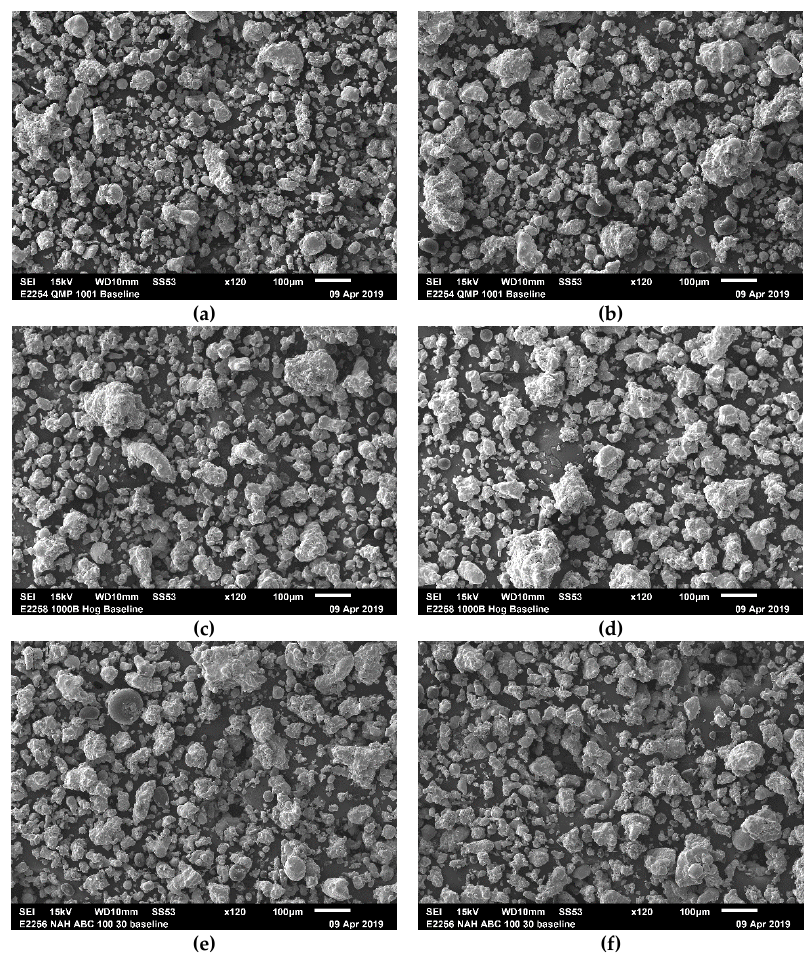
Figure 1. SEM images of as received iron powders, ( a ) and ( b ) are images for iron powder type A, ( c ) and ( d ) are images for iron powder type B and ( e ) and ( f ) are images for iron powder type C. For each iron powder type, the size distribution was established according to the ASTM (standard B214-16). It is clear from the histograms in Figure 2 that none of these distributions were